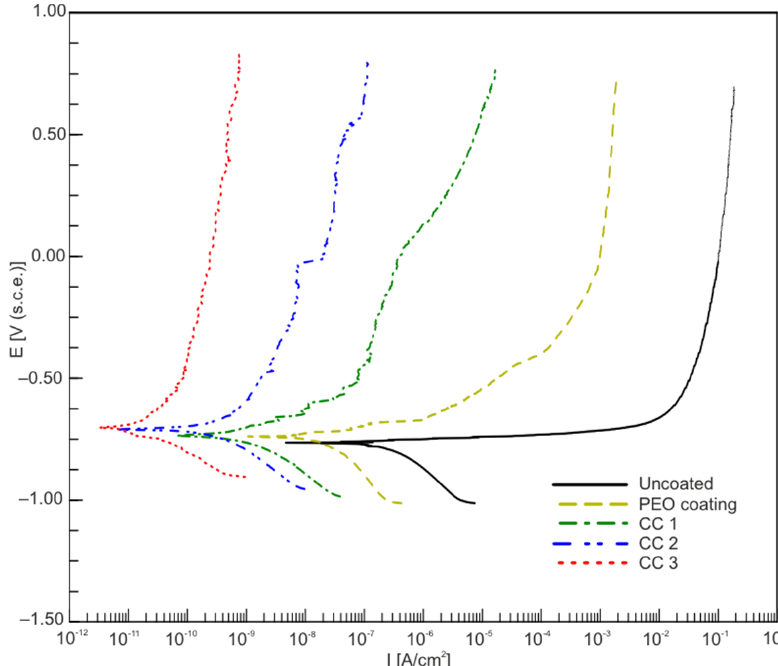
Figure 5. Polarization curves for samples made of AMg3 aluminum alloy with various types of surface treatment. Table 2. Corrosion properties (corrosion potential, E C , corrosion current density, I C , polarization re- sistance, and R P ) of samples made of AMg3 aluminum alloy with various types of surface treatment.